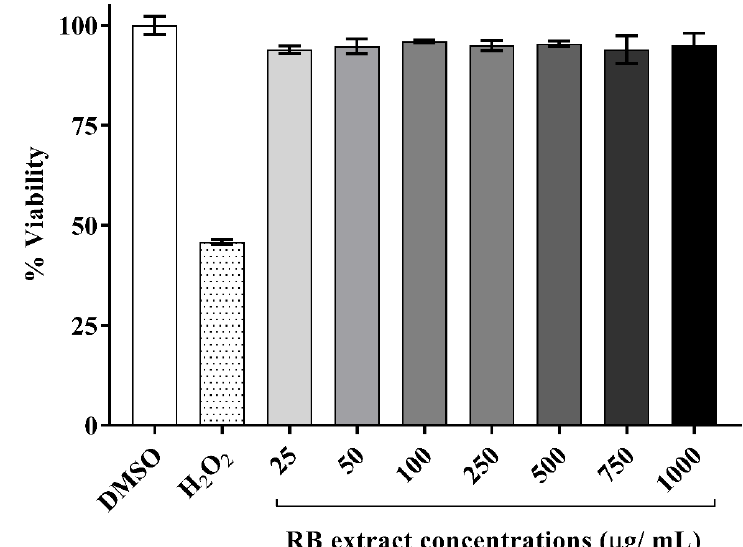
Figure 1. Cytotoxicity of RAW264.7 cells post-exposure to various doses of RB phenolic extracts (6 h treatment). The RB phenolic extracts did not display any cytotoxic effect on the RAW264.7 cells at the concentrations (25–1000 µ g / mL) tested ( n = 5). Data are presented as mean ± SD. Rice bran, RB.